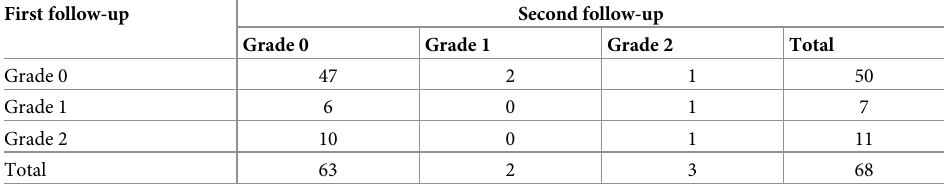
Table 3. Deformity among the RFT patients with relapse: Relapse and deformity among patients released from National Leprosy Eradication Programme of India: A cohort study from four districts in South